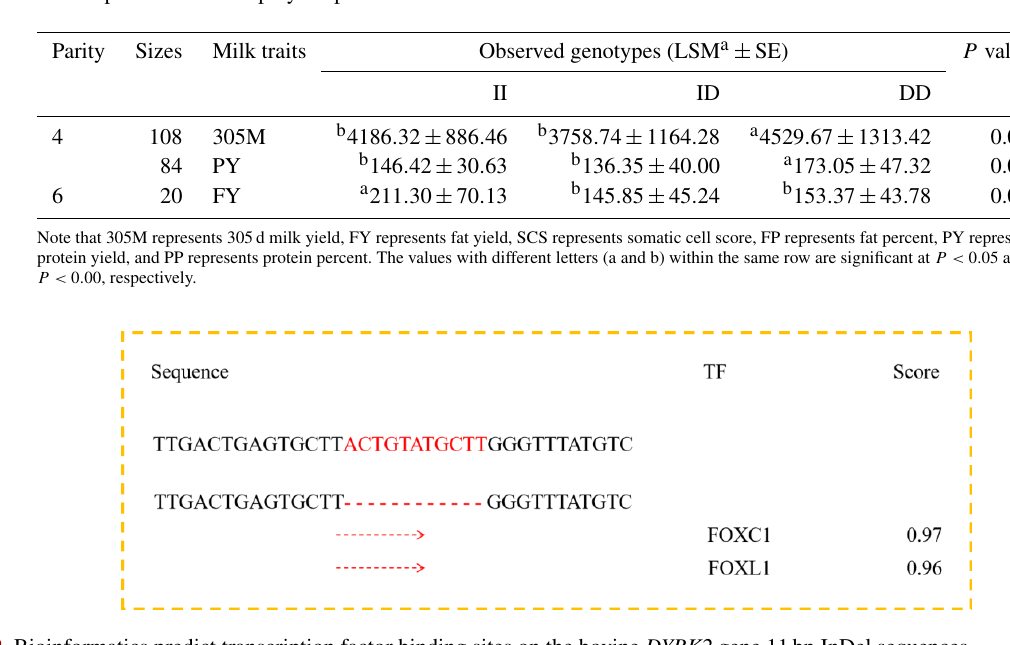
Table 3. Relationship between InDel polymorphism of DYRK2 -P3-D3 locus and milk traits of XJBC.